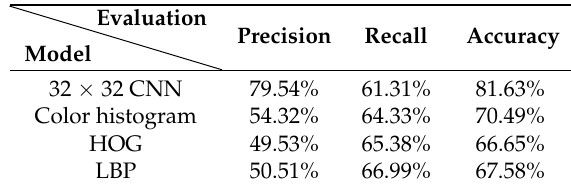
Table 6. Coarse chest classifier: Prediction result for the “dry hand” action. Positive class: dry hand, negative class: